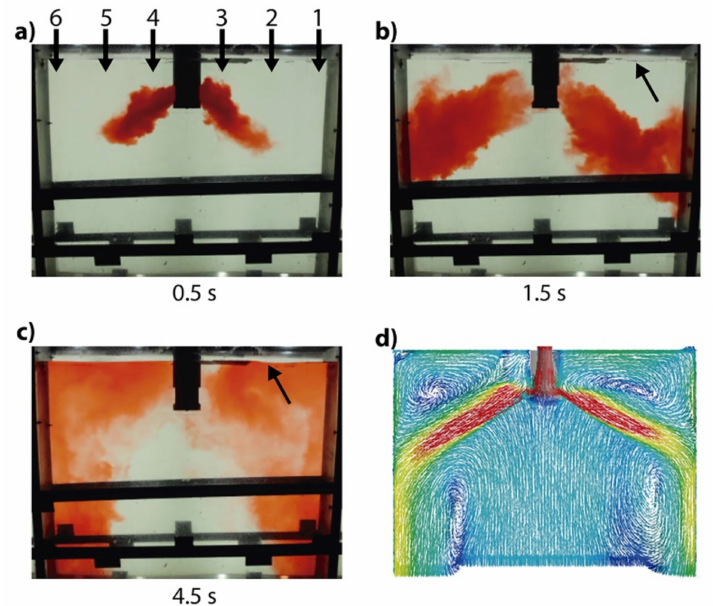
Figure 7. Tracer mixing in the mold model using nozzle A without clogging. ( a ) A total of 0.5 s after injection; the numbers indicate the positions of the sensors. ( b ) A total of 1.5 s after injection. ( c ) A total of 4.5 s after injection. ( d ) Numerical velocity field.